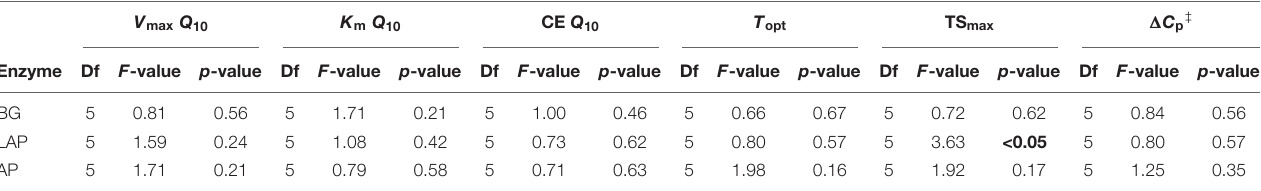
FIGURE 7 | Q 10 of Michaelis-Menten kinetic parameters over five temperatures from 4 to 35 ◦ C at different depths. (A) V max , (B) K m , and (C) CE. Differences between depths are not significant ( p > 0.05), based on one-way ANOVA tests per enzyme ( Table 4 ). Error bars represent the standard error of the mean ( n = 3). TABLE 4 | One-way ANOVA of temperature sensitivity estimates with depth per